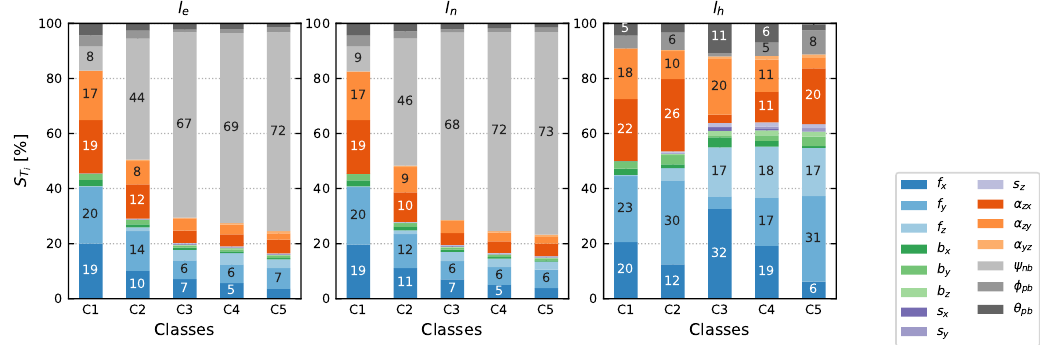
∗ 100 of IMU sensor model parameters, yaw ψ Figure 7. Total effect terms S T i mounting parameters ψ pb , θ pb on pole components for different pole tilts. The classes are defined similar to Figure